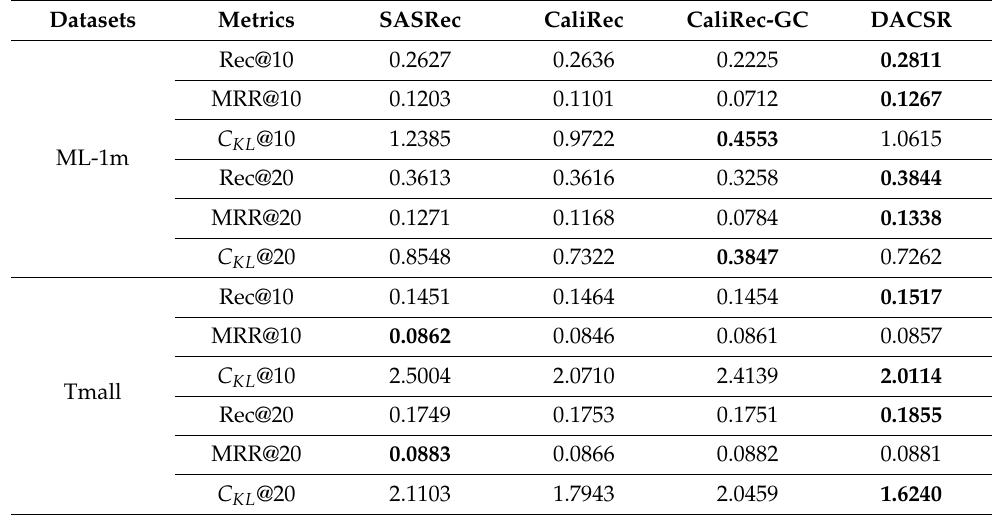
Table 2. Performances of our models and baselines (best performances are marked in bold).